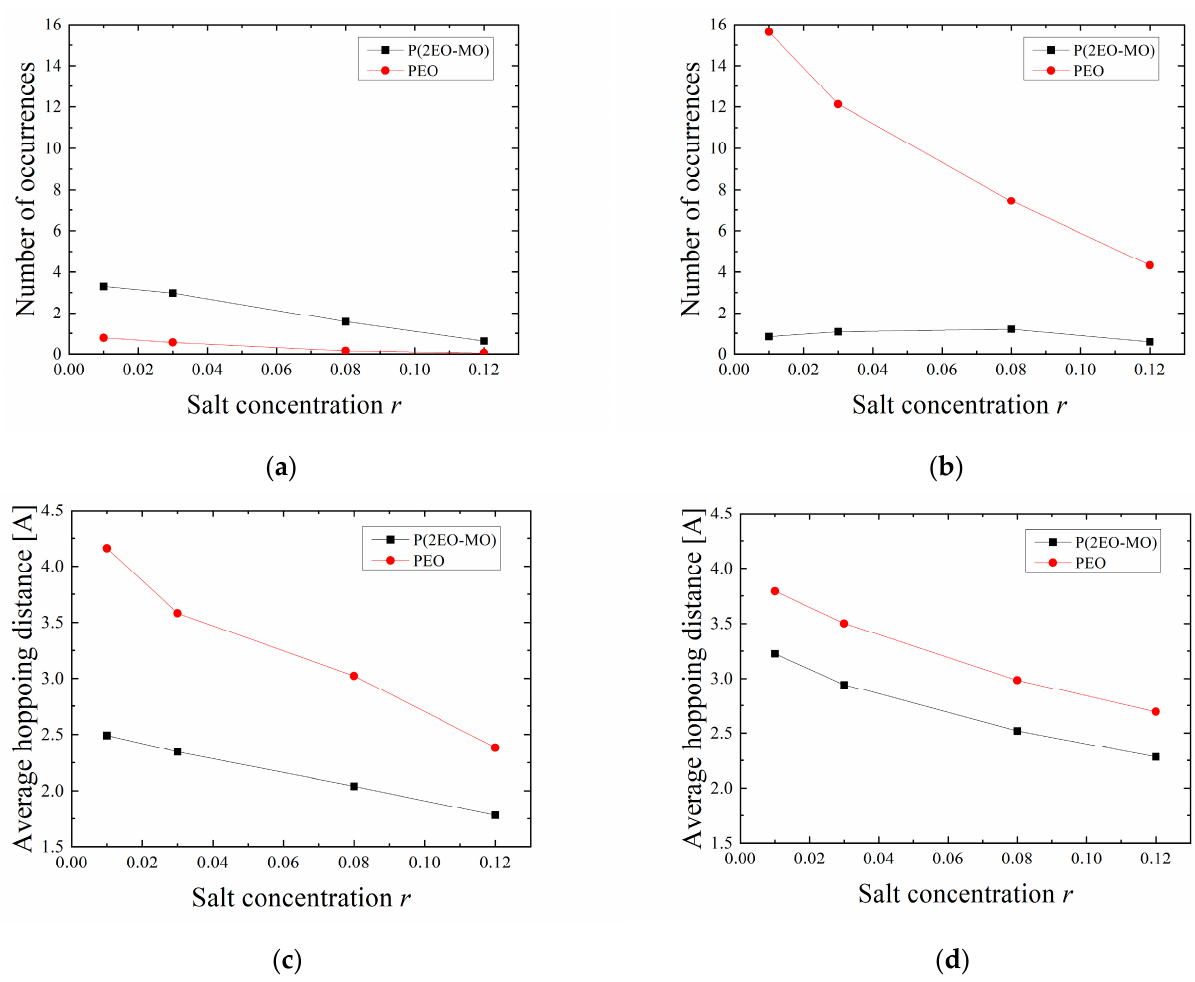
Figure 10. Number of occurrences of ( a ) inter-hopping and ( b ) intra-hopping. Average distance of ( c ) inter-hopping and ( d ) intra-hopping.